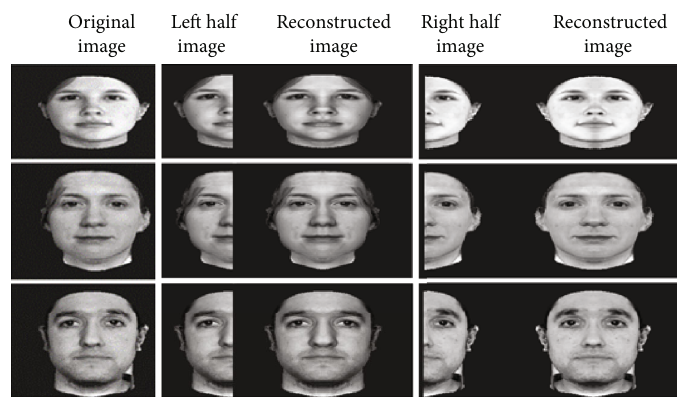
Figure 3: Reconstructed images from left and right segmented half images.